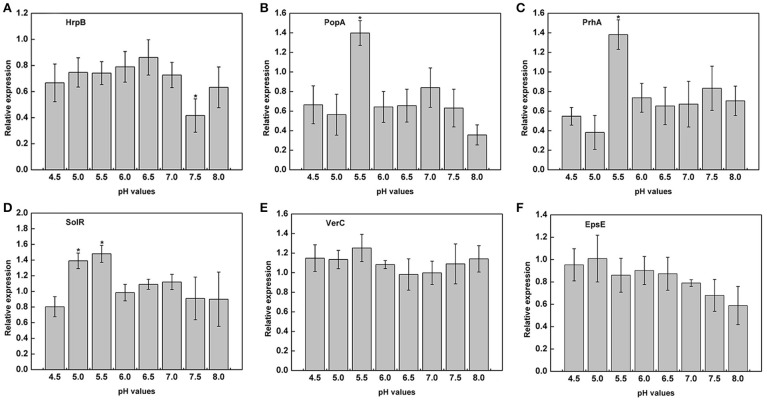
Expression of virulence genes under different pH conditions. The relative expression of six virulence genes in B medium with different pH was measured by RT-PCR. (A)
HrpB; (B)
PopA; (C)
PrhA; (D)
SolR; (E)
VerC; (F)
EpsE. SerC was used as a control gene to normalize the expression of the target genes. The results are the average value of three independent replicates. Error bars indicate the standard deviation (P < 0.05; ANOVA, Duncan's multiple test). The symbol “*” above the columns indicate significant differences among the different treatments (Duncan's test, p < 0.05).